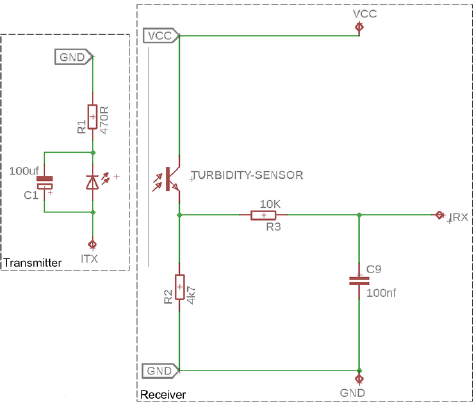
Figure 8. The aquatic monitoring platform turbidity sensor electronics schematic.